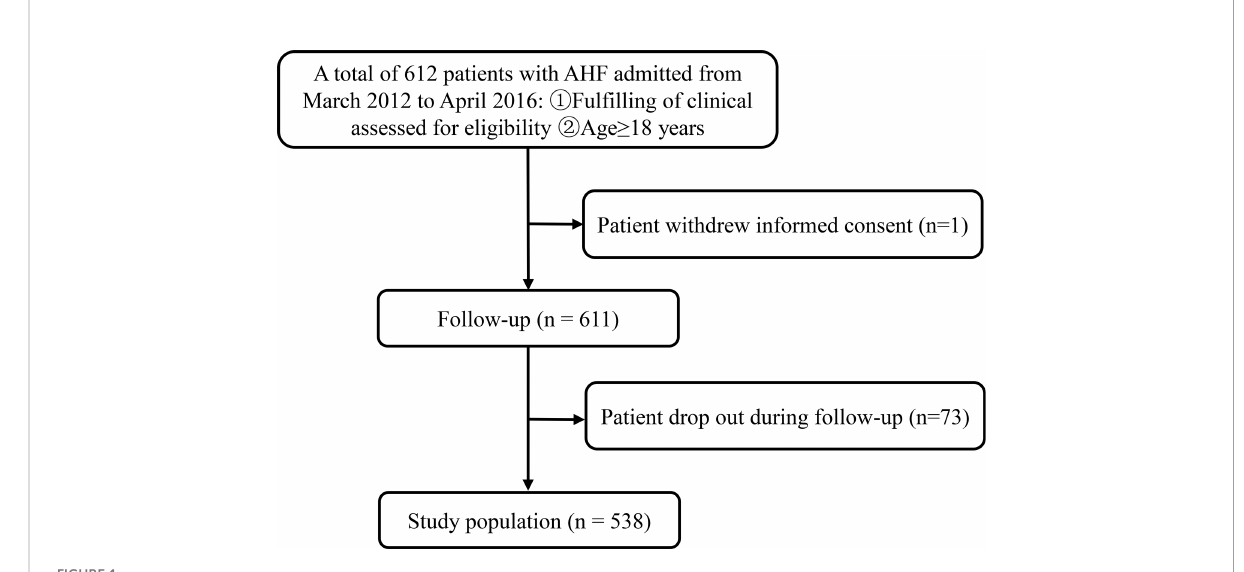
FIGURE 1 Flowchart of the study